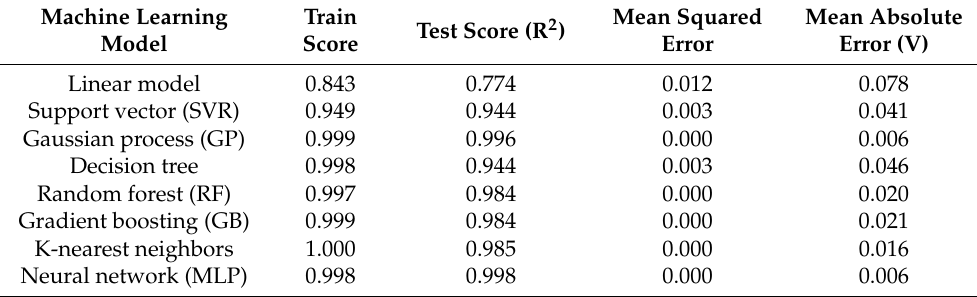
Table 3. Prediction accuracy and error of machine learning